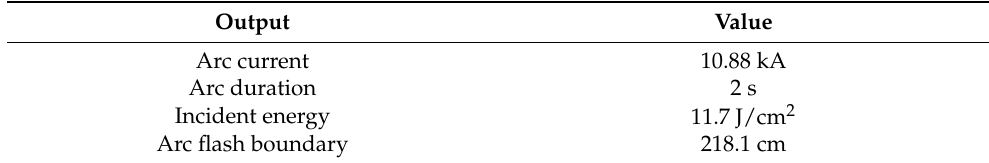
Figure 8. ArcPro simulation results—Case study 2. Table 5. ArcPro simulation results summary—Case study 2.